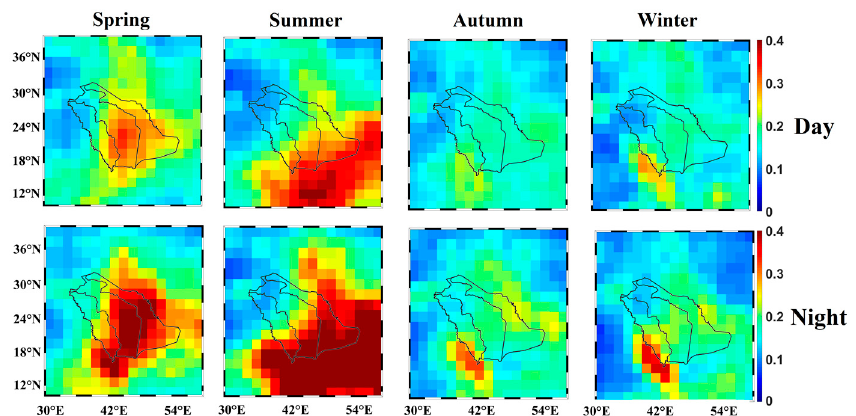
Figure 8. Seasonal spatial distributions of N over Saudi Arabia from 2007 to 2019.